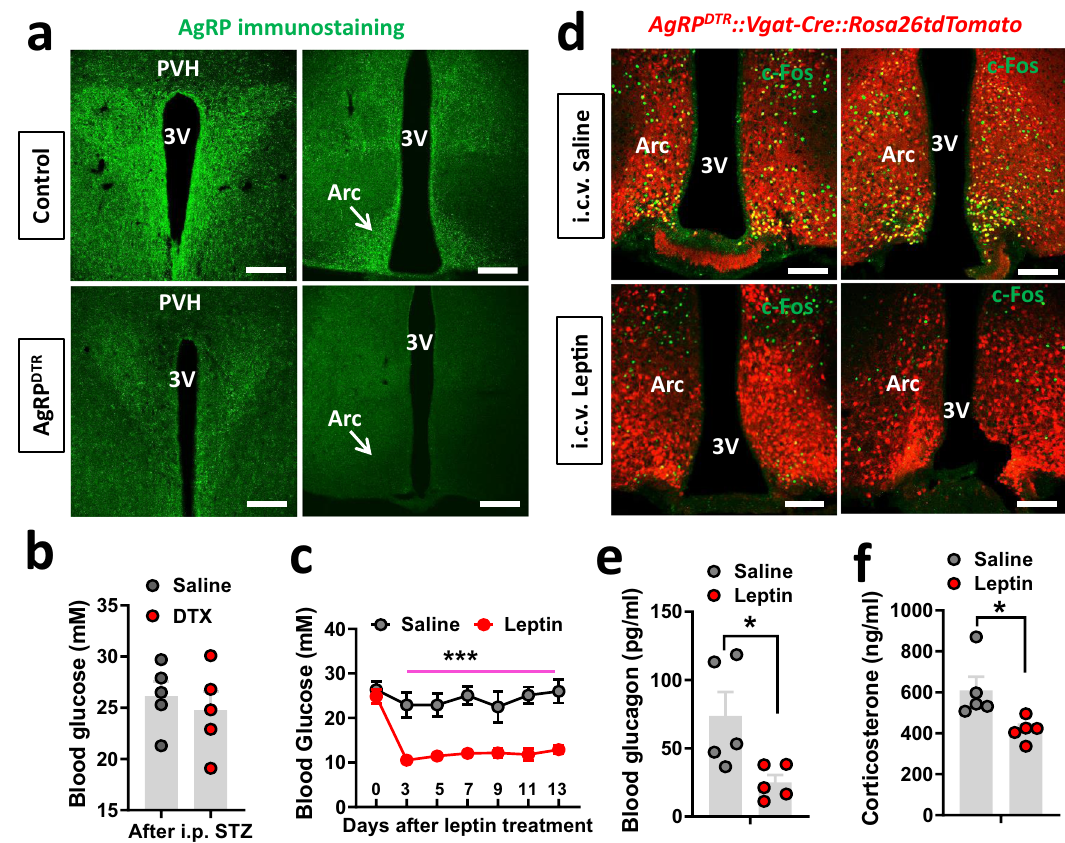
Fig. 5 AgRP neurons are not required for T1D hyperglycemia development and for leptin action in reducing T1D glucose. Vgat-Cre::Ai9::AgRP DTR mice were treated with DTX/saline at P3, made STZ-T1D at 8 – 9-weeks old, and then implanted with i.c.v. minipump for a 2-week leptin infusion. a Representative pictures from n = 3 mice showing immunostaining for AgRP in the Arc (right panels) and PVH (left panels) of both saline-treated controls (top) and the DTX-treated group (bottom). b Comparisons in blood glucose between saline and DTX-treated groups after STZ treatment (two-tailed unpaired Student ’ s t tests, n = 5/each, t = 0.6019, df = 8, P = 0.5639). c Reponses in glucose levels in DTX-treated Vgat-Cre::Ai9::AgRP DTR mice that received i.c.v. treatment of saline or leptin during the 14-day leptin treatment period (two-way ANOVA, n = 5/each, F (1, 56) = 150.4, *** P < 0.0001, saline vs leptin at day 13). d Representative sections from n = 2 mice showing expression of c-Fos (green) in Arc GABA + neurons (red) in i.c.v. saline-treated (left panel) and leptin-treated mice (right panel). e , f Comparisons in glucagon ( e , two-tailed unpaired Student ’ s t tests, n = 5/each, * P = 0.0266) and corticosterone ( f , two-tailed unpaired Student ’ s t tests, n = 5/each, * P = 0.027) at day 13 with i.c.v. leptin treatment. 3V the third ventricle, Arc arcuate nucleus. All data presented as mean ± SEM. Scale bar: 100 µ